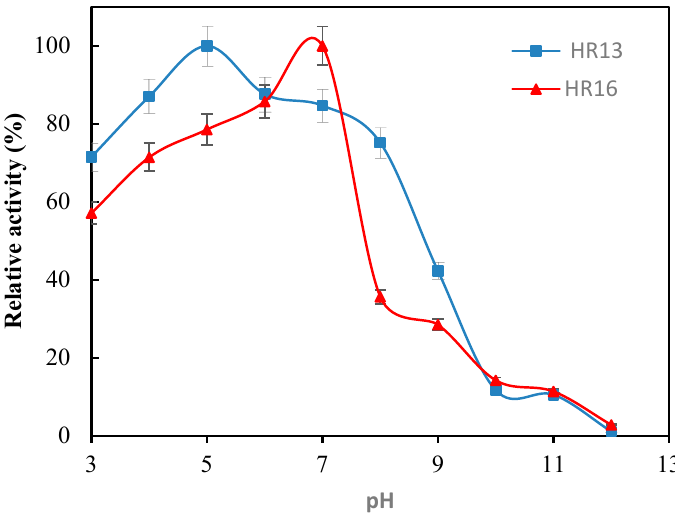
Figure 5. The impact of pH on the enzyme activity levels of HR13 ( ■ ) and HR16 ( ▲ ); the activity at the optimal pH was taken as 100%.